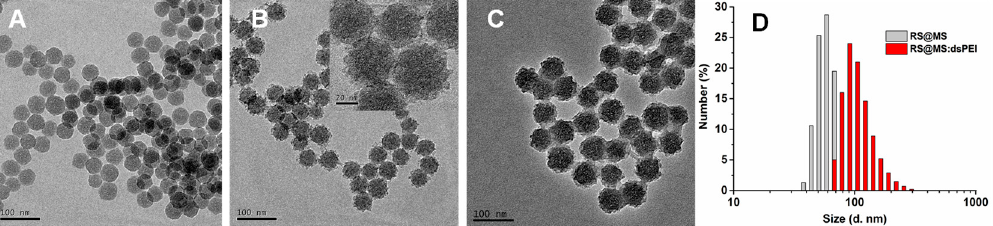
Figure 1. TEM images of ( A ) RS cores, ( B ) RS@MS core-shell nanoparticles, ( C ) RS@MS:dsPEI nanoparticles, and ( D ) particle sizes distribution of RS@MS and RS@MS:dsPEI. The inset in B is a magnified TEM image of the corresponding sample.